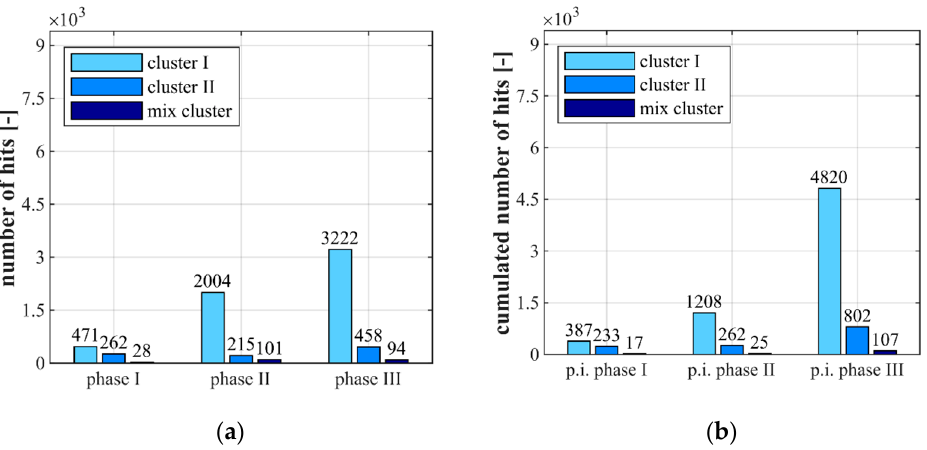
Figure 7. Clusters of AE-hits displayed for the entire duration of each phase ( a ) and displayed as cumulated AE-hits (i.e., including the hits from previous phases) up to the points of interruption (p.i.) ( b ) for S c,max = 0.85.